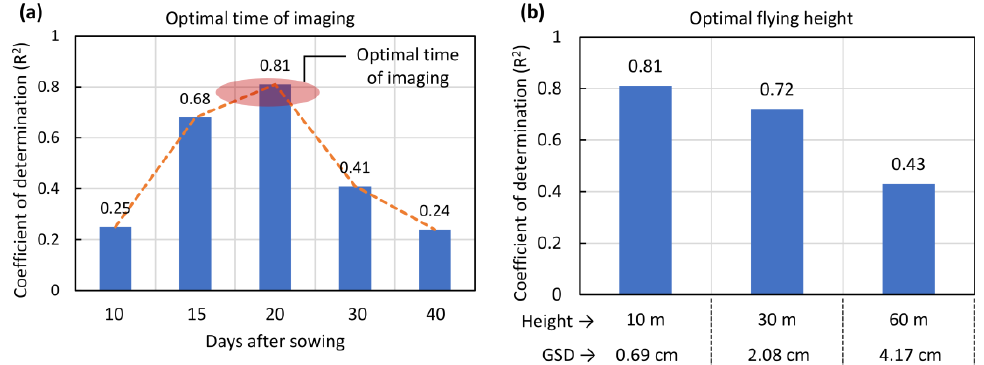
Figure 5. Cross-validation accuracy in GPR model development in terms of the coefficient of determination (R 2 ). (a) R 2 at different timing of aerial survey; (b) flying altitude of UAV. Note: the x-axis of bar graph plots is not linear.